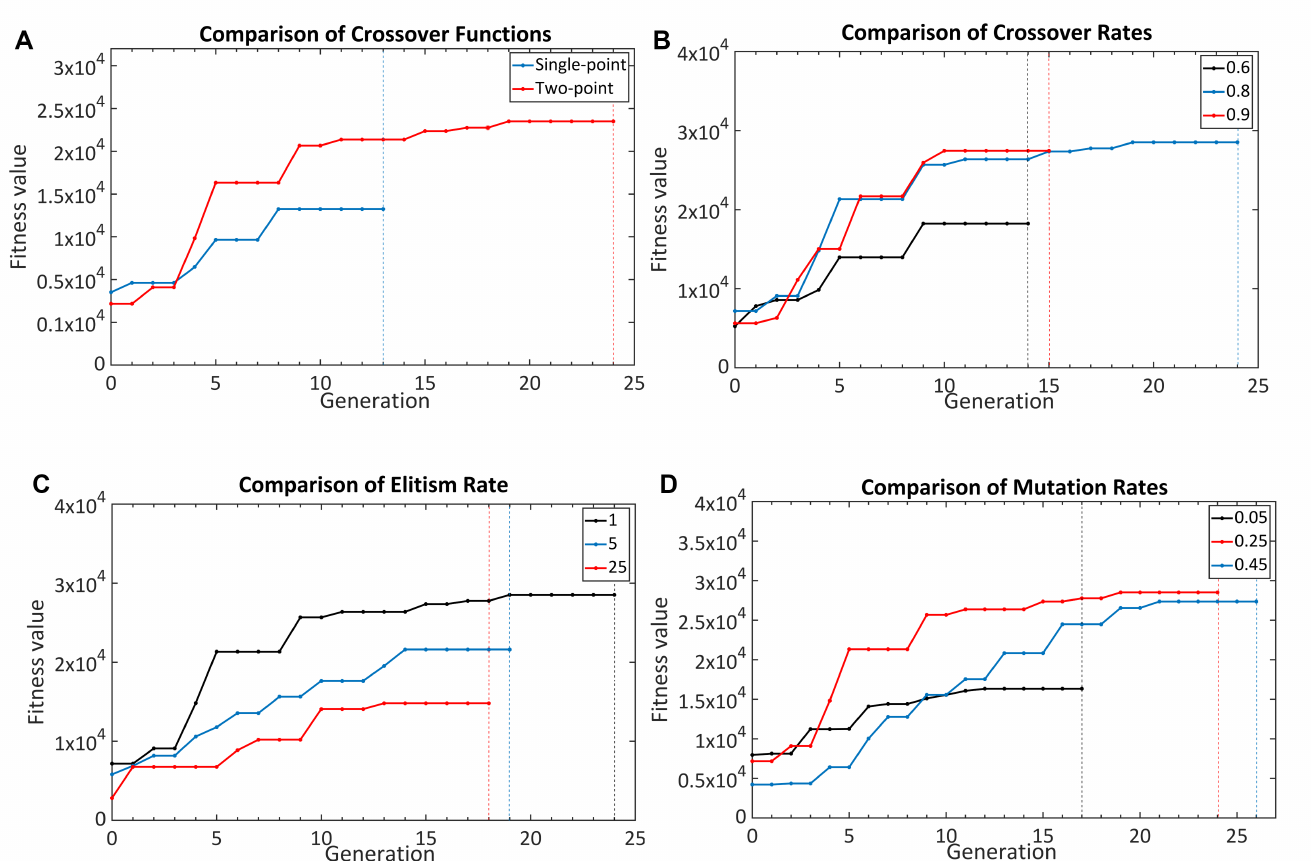
Figure 3. ( A ) Comparison of two different crossover functions. The two-point crossover function improves the performance of the GA due to the increased variety. ( B ) The effect of the crossover rate on the optimization performance. The crossover rate of 0.8 was set as the optimal parameter according to the obtained fitness values. ( C ) The effect of the elitism rates on the GA optimization. The optimal parameter for elitism is 1. ( D ) The effect of different mutation rates on the GA optimization. The mutation rate should be selected between 0.05 and